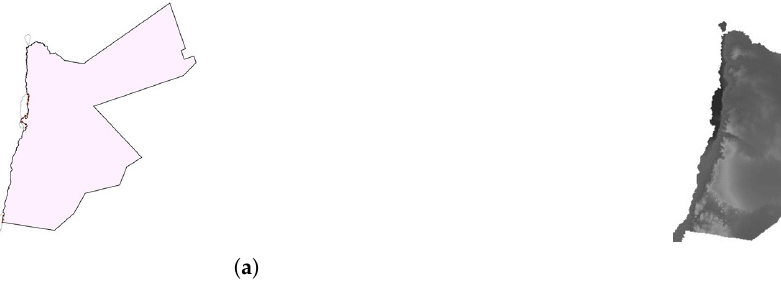
Figure 3. The clipped DEM raster image based on country shape of Jordan map (obtained from [7]). ( a ) Country shape of Jordan map. ( b ) Clipped DEM raster image of